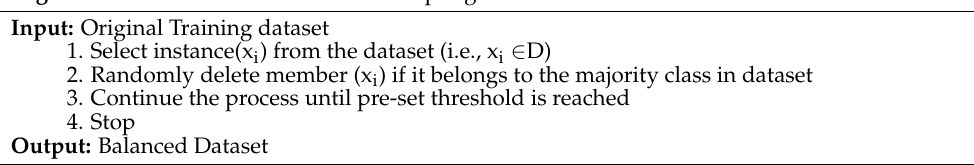
Algorithm 1: Pseudo code for Under